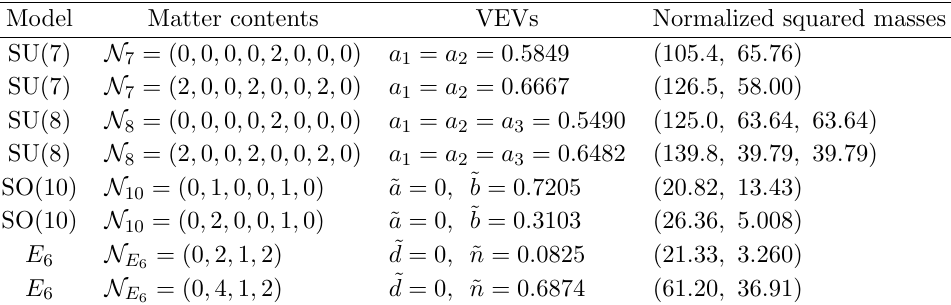
Table 1 . Examples of vacuum con(cid:12)gurations in SU(7), SU(8), SO(10), and E 6 models. Matter contents, VEVs at the global minimum of the one-loop e(cid:11)ective potentials, and physical squared mass eigenvalues of A 5 zero modes normalized by the typical mass parameter m 2 are